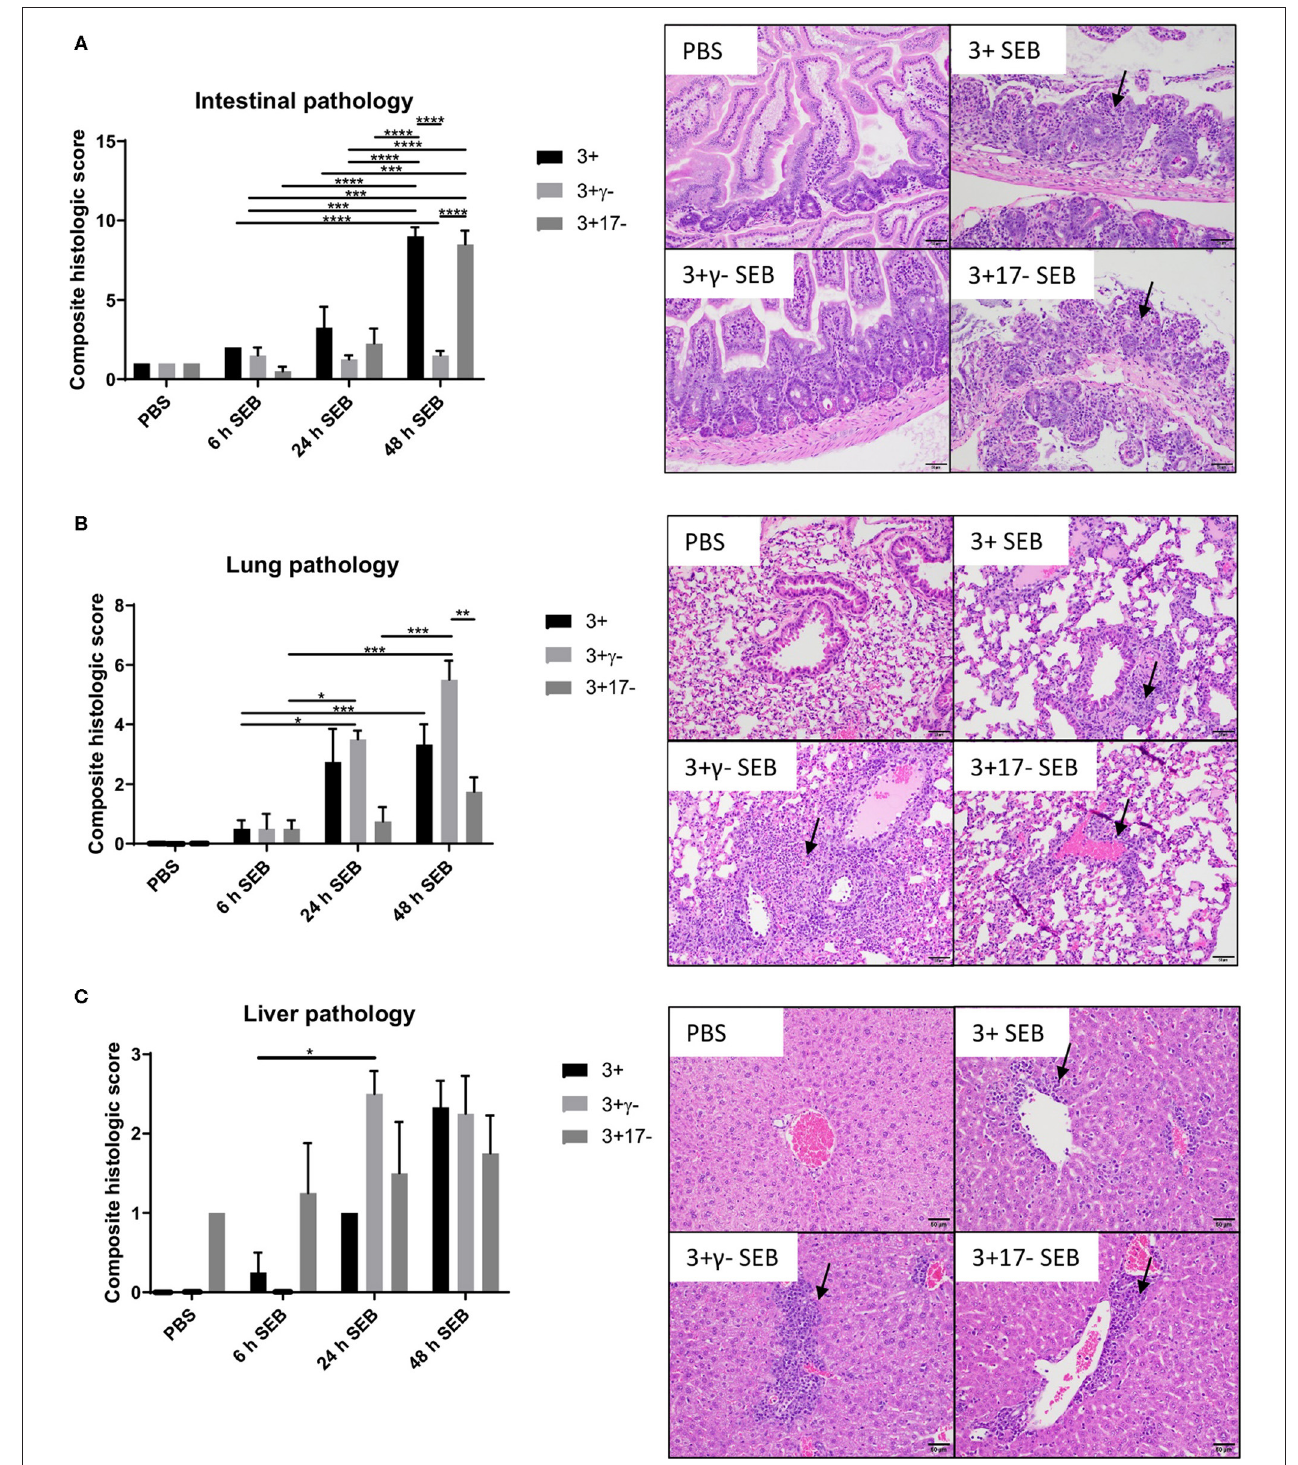
FIGURE 2 | IFN- γ and IL-17A deficiency differentially modulate organ pathology associated with SAg-induced CRS. HLA-DR3.WT, DR3.IFN- γ ◦ , and DR3.IL-17 ◦ mice were challenged with 50 µ g of SEB in 200 µ l of PBS by intraperitoneal route. Groups of mice were euthanized at indicated time points and organs collected in buffered formalin. Tissues were embedded in paraffin, processed, and stained with hematoxylin and eosin as per the standard procedure. Stained sections of (A) small intestine, (B) lung, and (C) liver were then graded by a board-certified veterinary pathologist (SCO) in a blinded fashion. Panels on the right shows representative images of H&E stained slides (from 48h group) of certain fields taken at 20x magnification. Scores mean ± SD from 4 to 8 mice per group. * p < 0.05, ** p < 0.005, *** p < 0.0005, **** p < 0.0001.